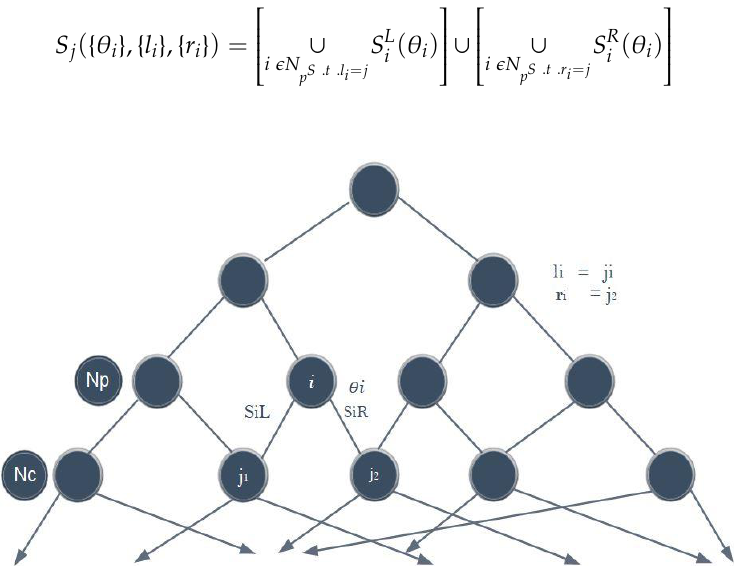
Figure 2. Decision jungles (DAGs).